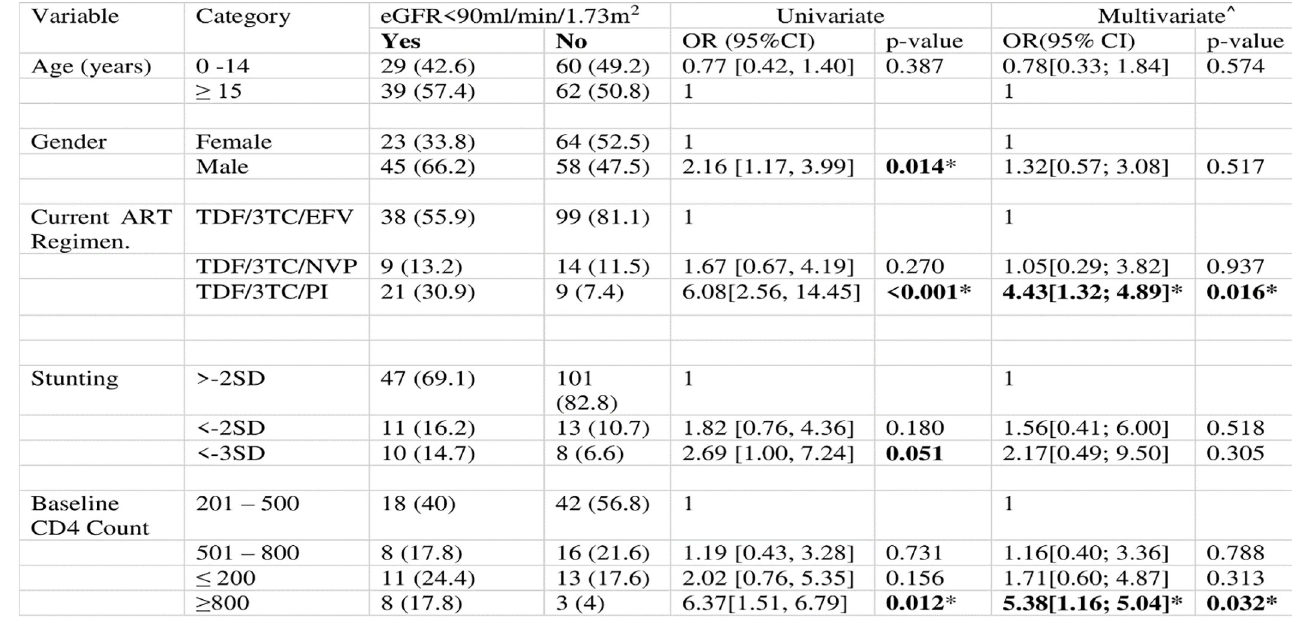
Fig 2. Factors associated with reduction in eGFR in HIV infected children, on TDF for at least 6 months, < 18 years old, (n.190) † . Children less than 18 years who weighed at least 25 kg and were on a TDF based regimen for at least six months were eligible for the study. Participants with pre-existing diabetes or hypertension were excluded from the study. Following serum creatinine determination estimated glomerular filtration rate (eGFR) was calculated using the Schwartz formula. † 8 samples not processed due to a technical fault at laboratory. � Statistically significant at α = 0.05. ^ Only age had a p-value greater than 0.25 in the univariate model but it was also included in the multivariate model to account for any confounding effects age may have on eGFR.